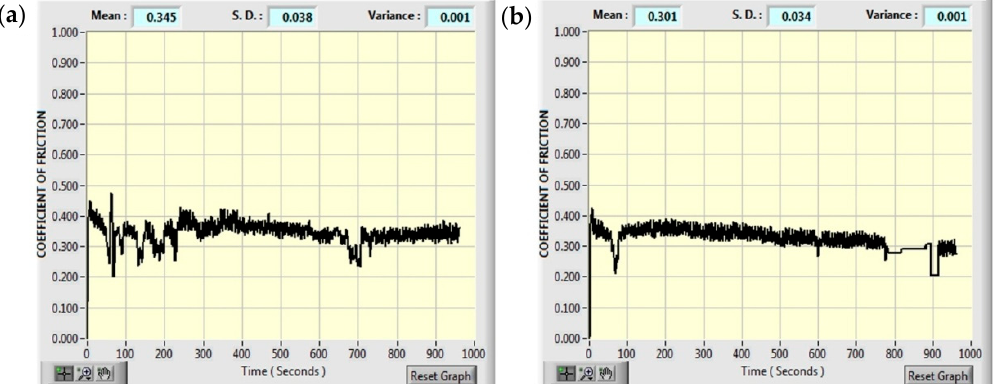
Figure 11. Evolution of the coefficients of friction: ( a ) AA5083/nano-SiC, and ( b ) AA5083/micro-SiC.